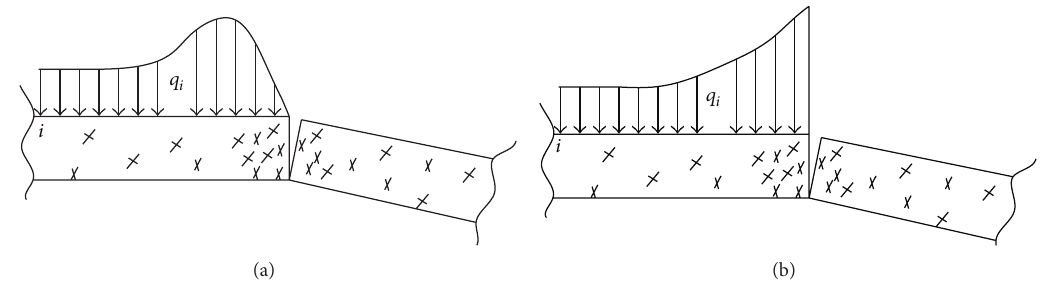
Figure 3: The abutment stress distribution of strata.